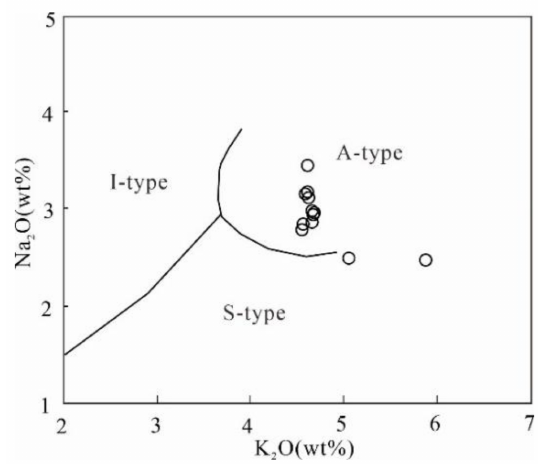
Figure 8. Na 2 O-K 2 O discrimination diagram of the LG.